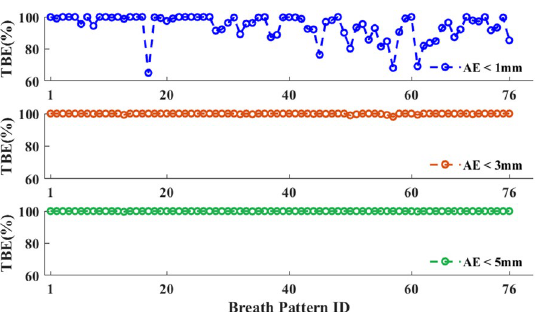
Figure 6. TBE for AE < 1 mm (blue), AE < 3 mm (orange), and AE < 5 mm (green). (Testing conditions: N = 14 , N ′ = 12 , h p = 10, t p = 333 ms, k tr = 600 ).